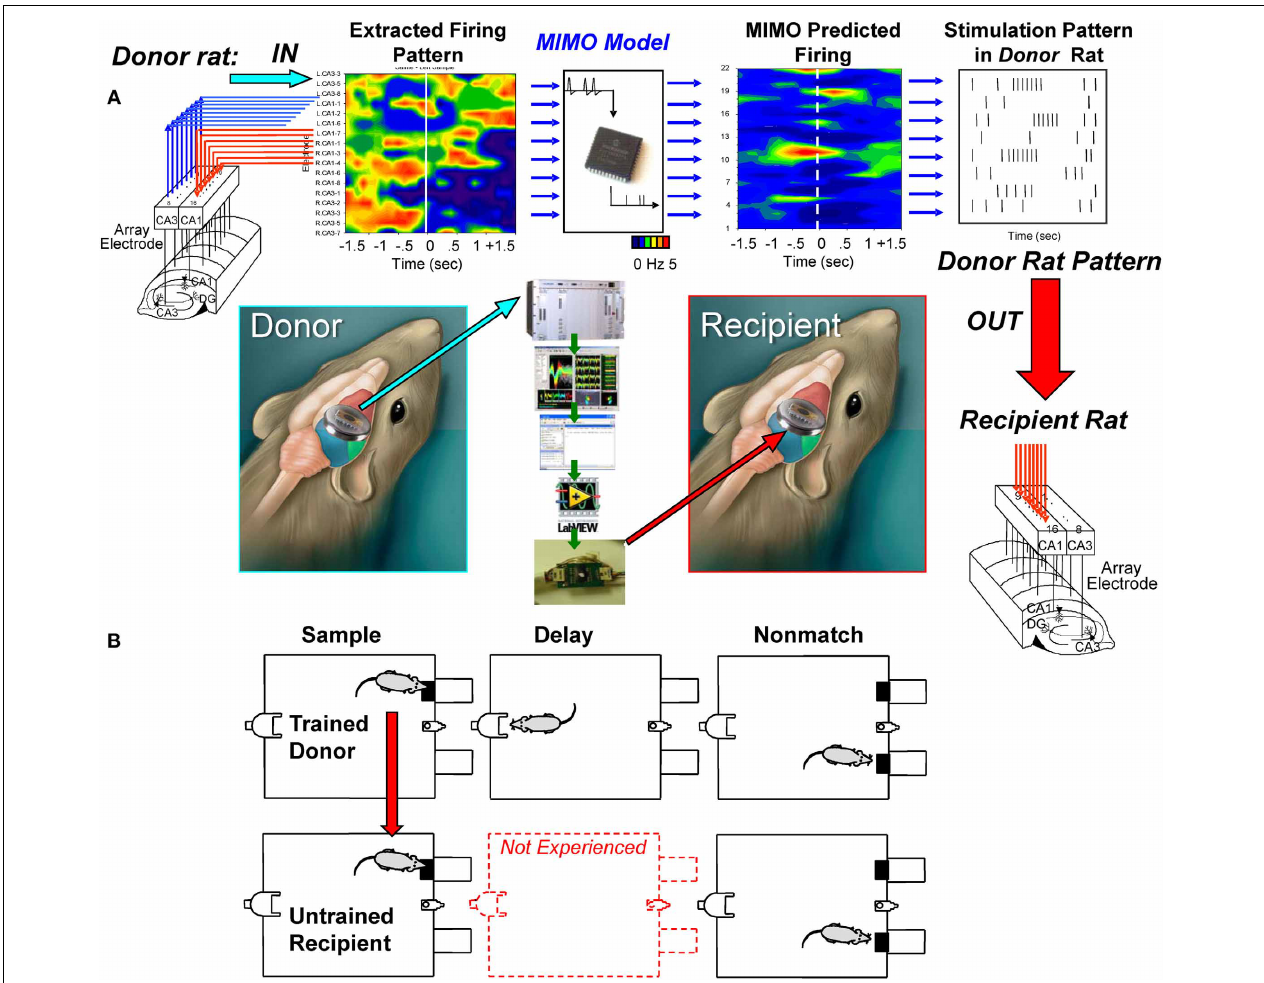
FIGURE 3 | Transference of successful MIMO coded ensemble firing patterns from trained “ donor ” rats to task-naïve “ recipient ” rats. (A) Recordings were obtained online from well-trained animals (i.e., donor rats ) with validated effective MIMO SR CA1 stimulation patterns as shown in Figure 2 . A second group of delay-naïve animals ( recipient rats ) were only trained to perform the operant responses in the DNMS task in sequence without exposure to variable and extended delay intervals interposed between the SR and NR task phases requiring completion of the nosepoke response on the opposite wall (red middle diagram). (B) Donor-Recipient rat “pairs” were recorded from and tested simultaneously in different chambers with DNMS trial execution synchronized by presentation of the sample lever in the same position at the same time. During performance of trials within the simultaneous